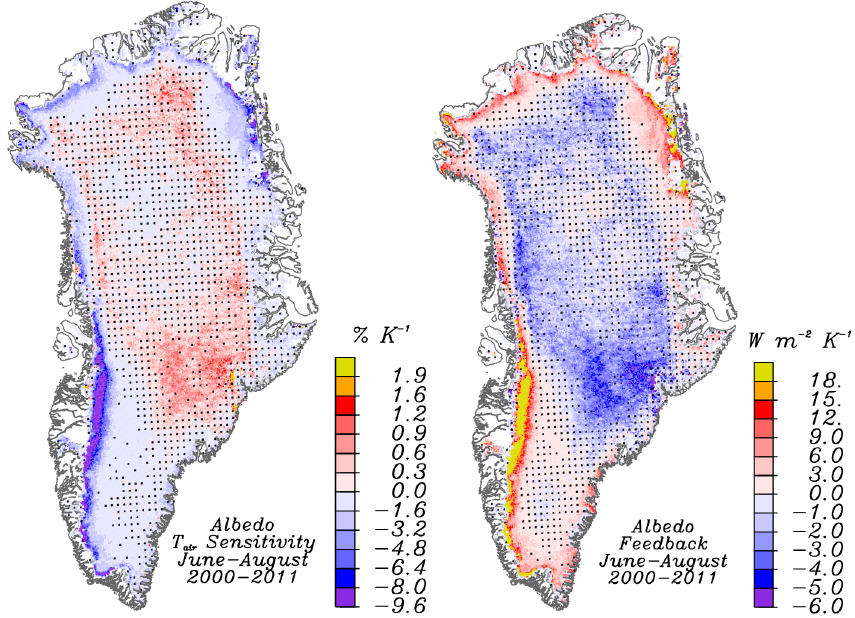
Fig. 13. (a) Summer (JJA) spatial patterns of MODIS MOD10A1 albedo sensitivity to the MAR-simulated surface air temperature. The positive scale is one-fifth that of the negative scale. (b) Summer spatial patterns of ice sheet albedo feedback based on MODIS albedo observations and calibrated MAR simulations of S ↓ , and T air . The negative albedo feedback scale is one-third that of the positive scale. The regressions are detrended to minimize spurious correlation. Stippled areas have trends that are not statistically significant above 80% confidence.